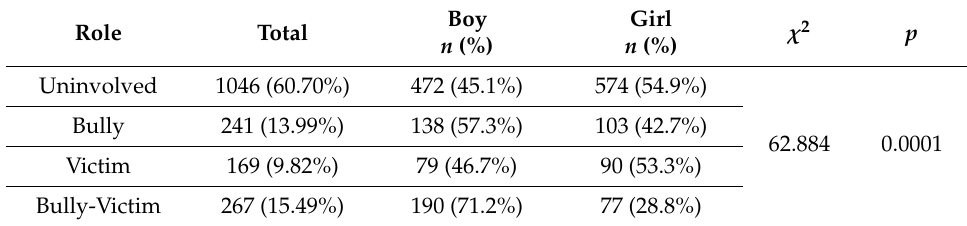
Table 2. Frequency and Percentage of Homophobic Verbal Content Bullying by